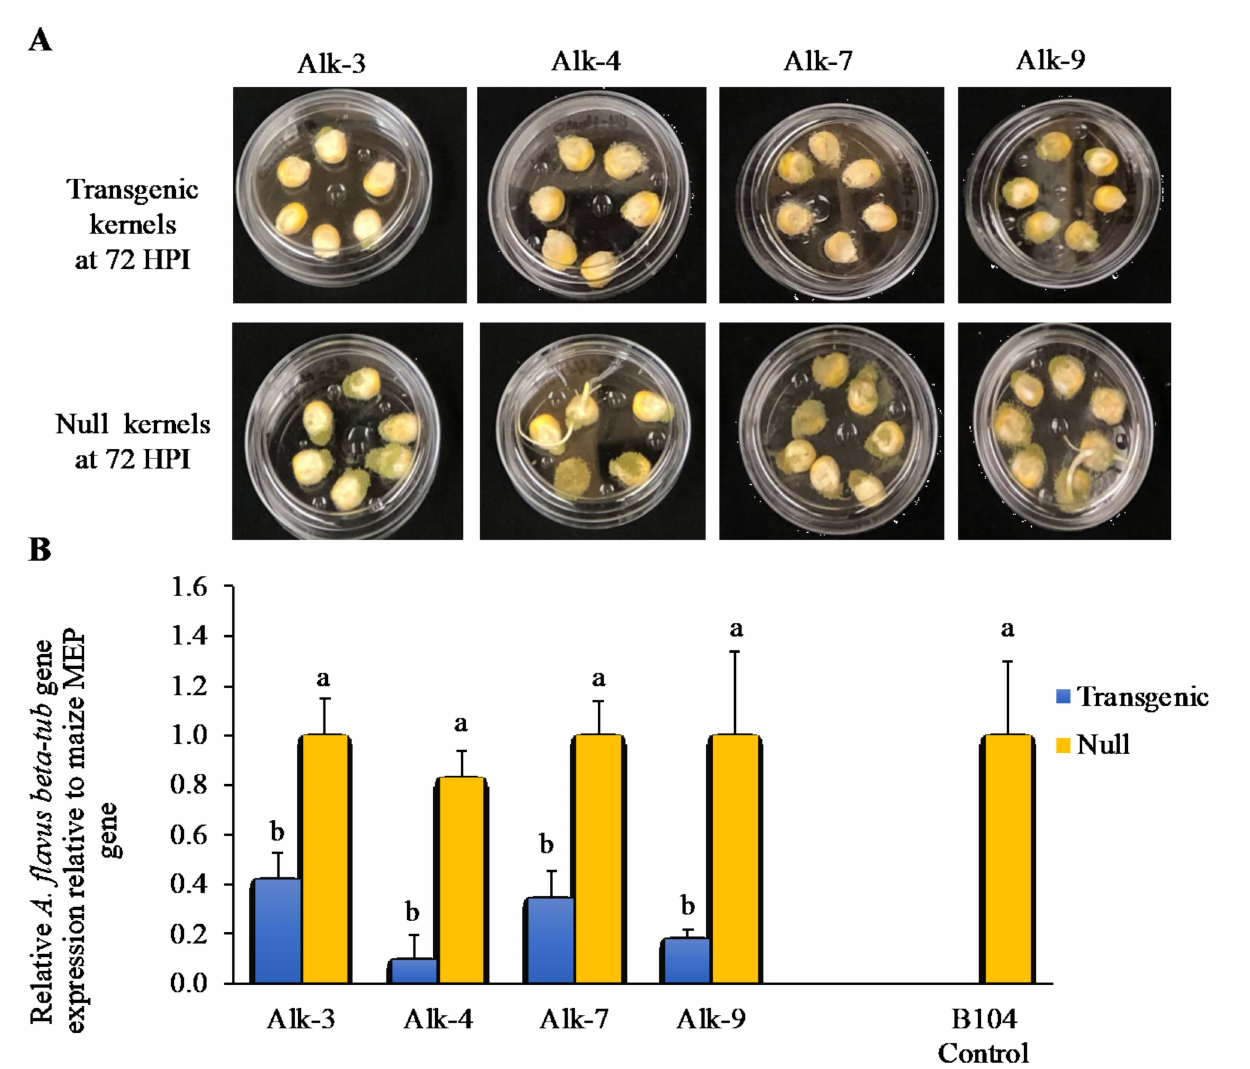
Figure 5. A. flavus growth inside inoculated Alk-RNAi and null maize kernels. ( A ) Transgenic maize kernels (top) and the null kernels (bottom) from the respective events 72 h after A. flavus inoculation. ( B ) The levels of β eta-tubulin DNA in the inoculated transgenic and null kernels relative to the DNA of maize membrane protein (MEP) gene. Significantly lower A. flavus biomass (based on the level of A. flavus β -tub DNA) were detected in the transgenic compared to the null kernels in all four events. Each of the bars represents the mean value ± standard deviation of three replicates per sample. Bars with different letters are significantly different ( p <